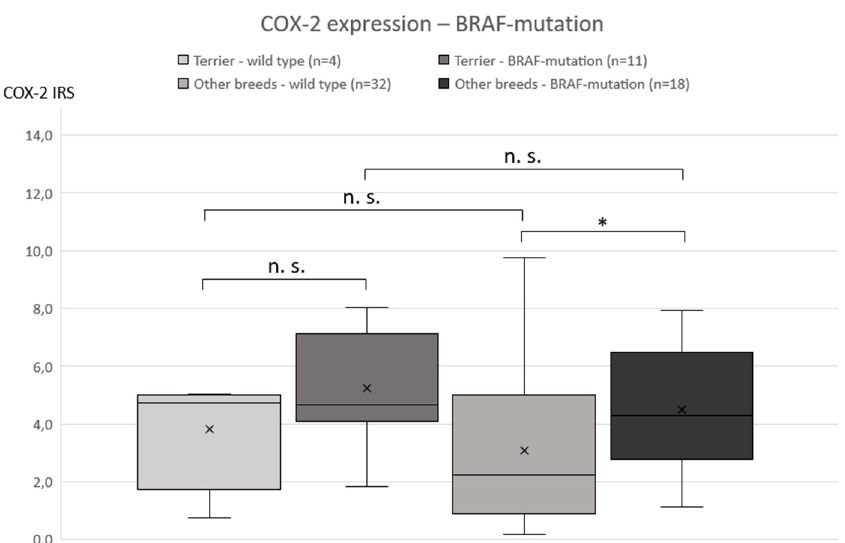
Figure 6. Correlation between the intensity of cyclooxygenase-2 expression and the presence or absence of BRAF mutation: a significant difference in the cyclooxygenase-2 expression was only detected in non-terrier breeds comparing BRAF mutation-positive and -negative transitional cell carcinoma (Mann–Whitney U -test, p ≤ 0.05).